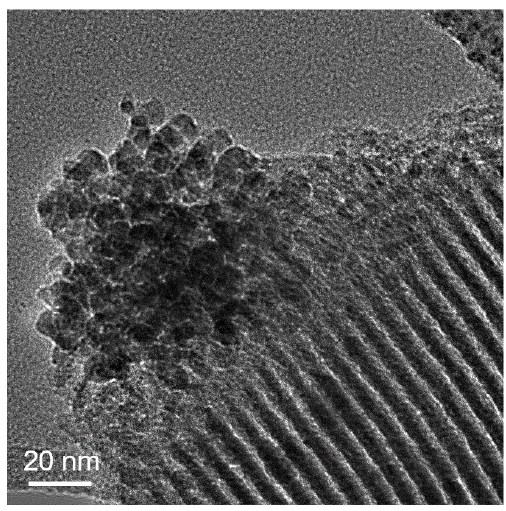
Figure 2. Representative TEM image of WI-Pd/SBA-15.